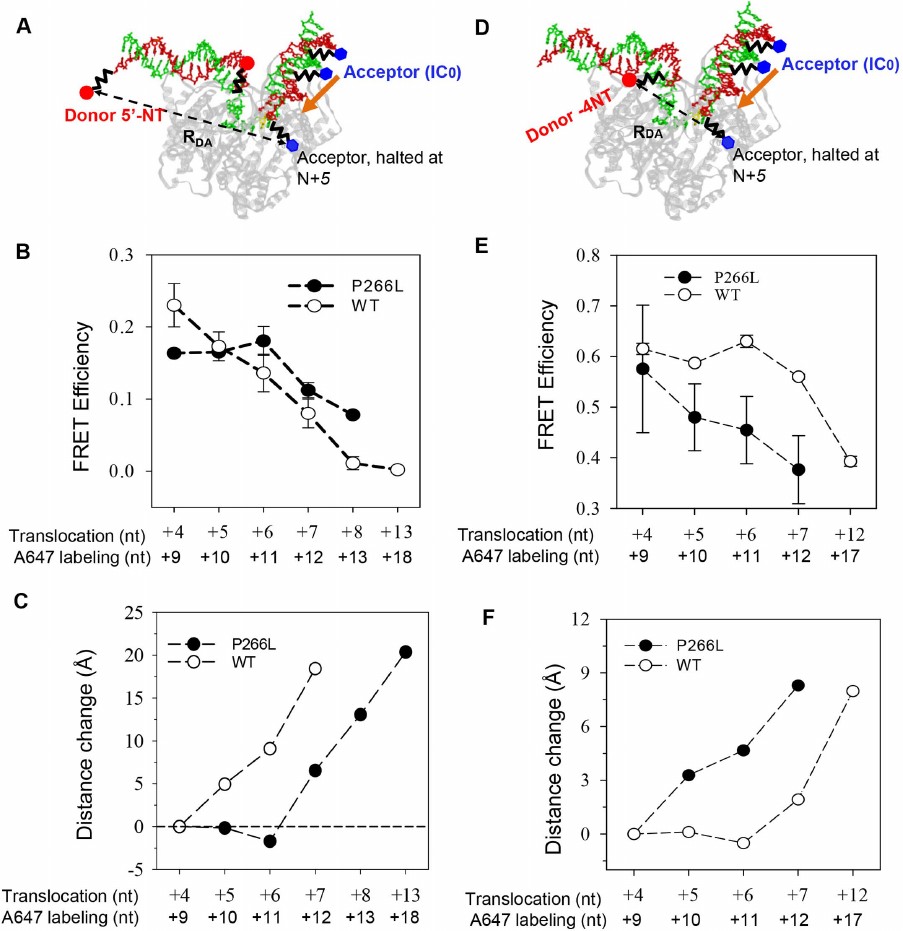
Figure 6. The P266L mutation modifies both rotation and DNA scrunching changes during initiation. (A) Cartoon illustration of FRET experiments to measure promoter rotation. The polymerase is in gray, the non-template strand in red and the template in green. Fluorescent donor TAMRA (red sphere) was introduced at position 2 22 in the non-template strand and acceptor Alexa 647 (blue square) at designated downstream positions on the template strand. Transcription complexes were walked to position N ( + 4 to + 13) and FRET efficiency between donor (D) at 2 22 and acceptor (A) at N + 5 was measured to obtain the D-A distances (R DA , discontinuous line). (B and C) Average FRET efficiency and changes in D-A spatial distances are shown for P266L and WT T7 RNAP (D) Cartoon illustration of FRET experiments to measure DNA scrunching. The donor Cy3 (red sphere) was labeled on position 2 4 and acceptor Cy5 (blue square) labeled on downstream N + 5 positions as above. (E and F) Average FRET efficiency and changes in averaged D-A spatial distances between Cy3 at the upstream edge ( 2 4) and Cy5 at the downstream N + 5 positions with the P266L and WT T7 RNAP complexes. The error bars of FRET efficiency represent the standard deviations from multiple independent measurements (N $ 3).